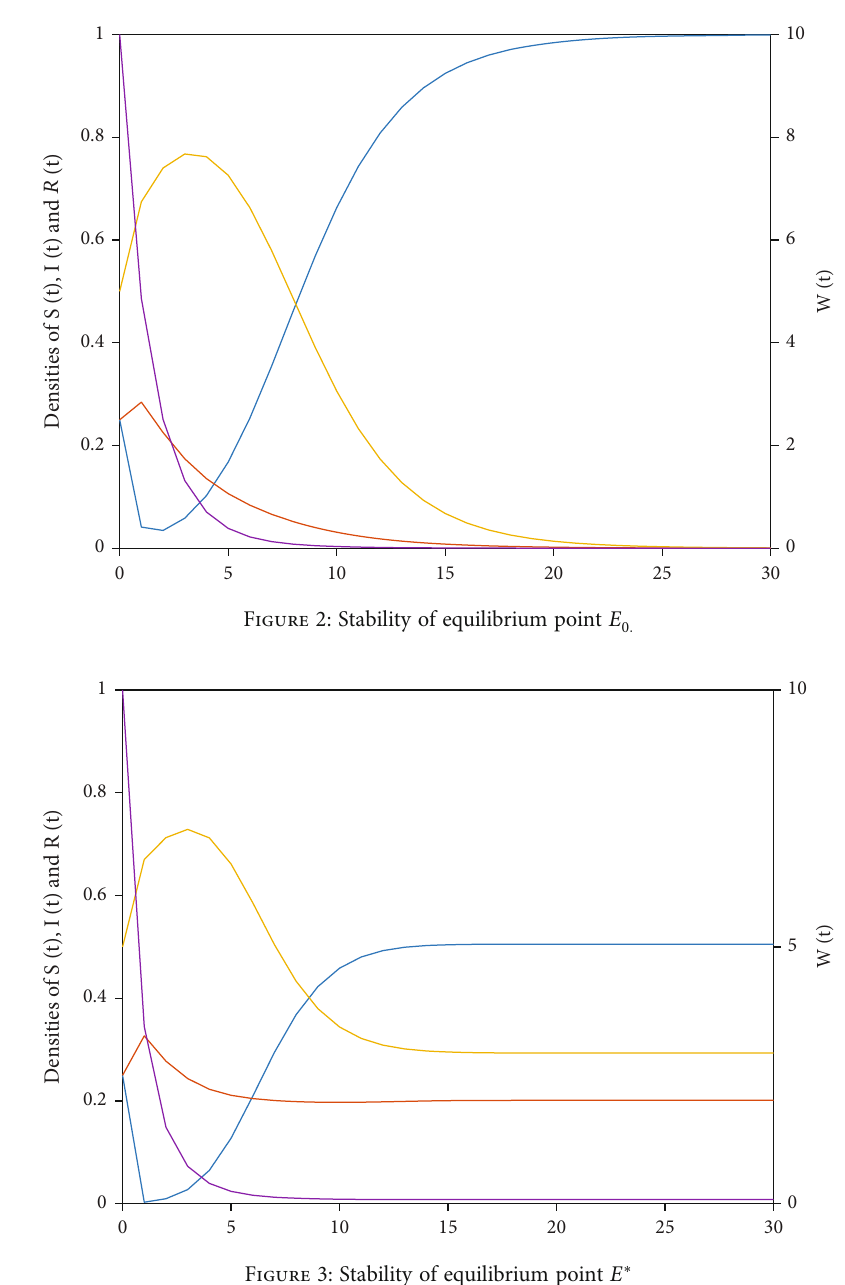
Figure 3: Stability of equilibrium point E ∗